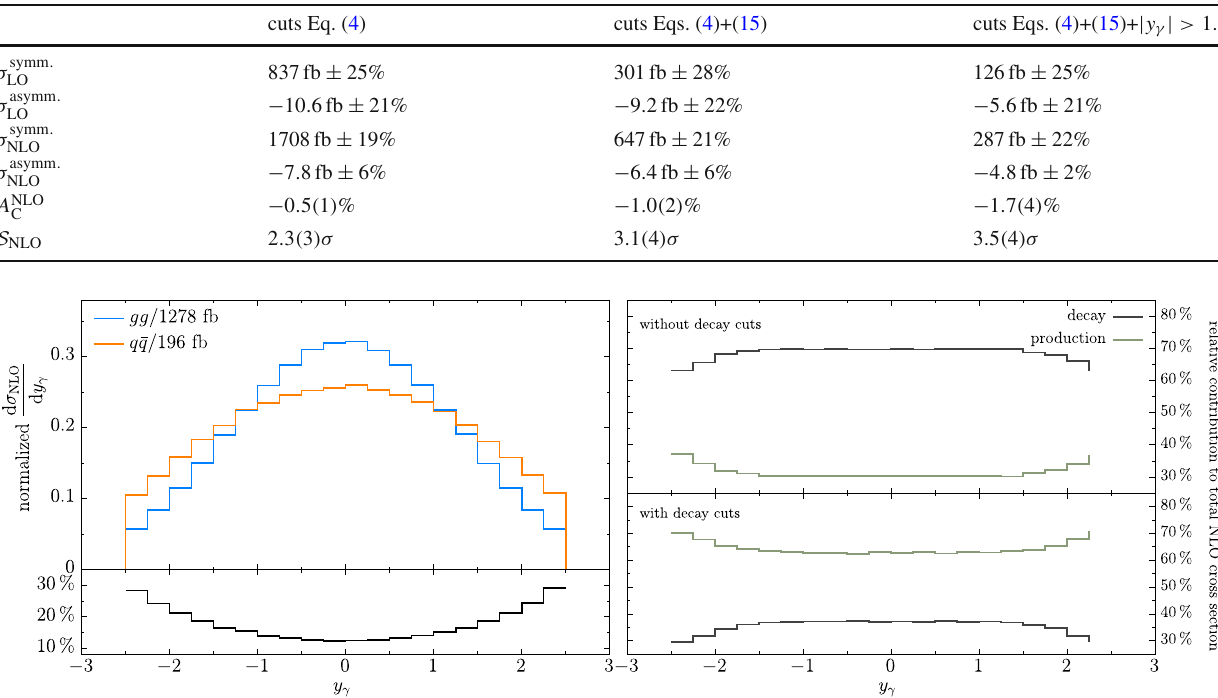
decay with respect to the total contribution as a function of the photon rapidity.TheupperpaneincludestheselectioncutsinEq.(4).Thelower pane includes the suppression cuts in Eq. (15) in addition to Eq.